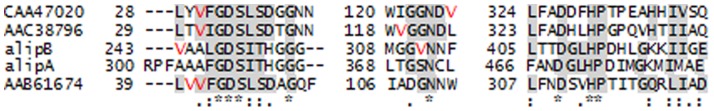
Conserved sequence motifs of alipA and alipB and lipolytic enzymes from the GDSL family.Alignment of Pfam conserved domains. The accession numbers of the aligned sequences are for the following organisms: CAA47020, triacylglycerol lipase from Photorhabdus luminescens; AAC38796, outer membrane esterase from Salmonella typhimurium; AAB61674, lipase/esterase from Pseudomonas aeruginosa PAO1. Conserved motifs are highlighted. The possible catalytic triad (Serine (S), Aspartic acid (D), Histidine (H)) is shown at the top of the alignment whenever necessary.